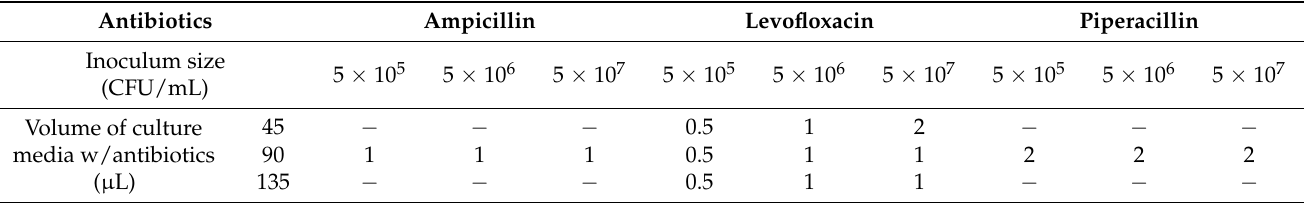
Table 4. MIC values of E. feacalis according to different bacterial inoculum sizes and volumes of culture media with antibiotics. The unit of MIC is µ